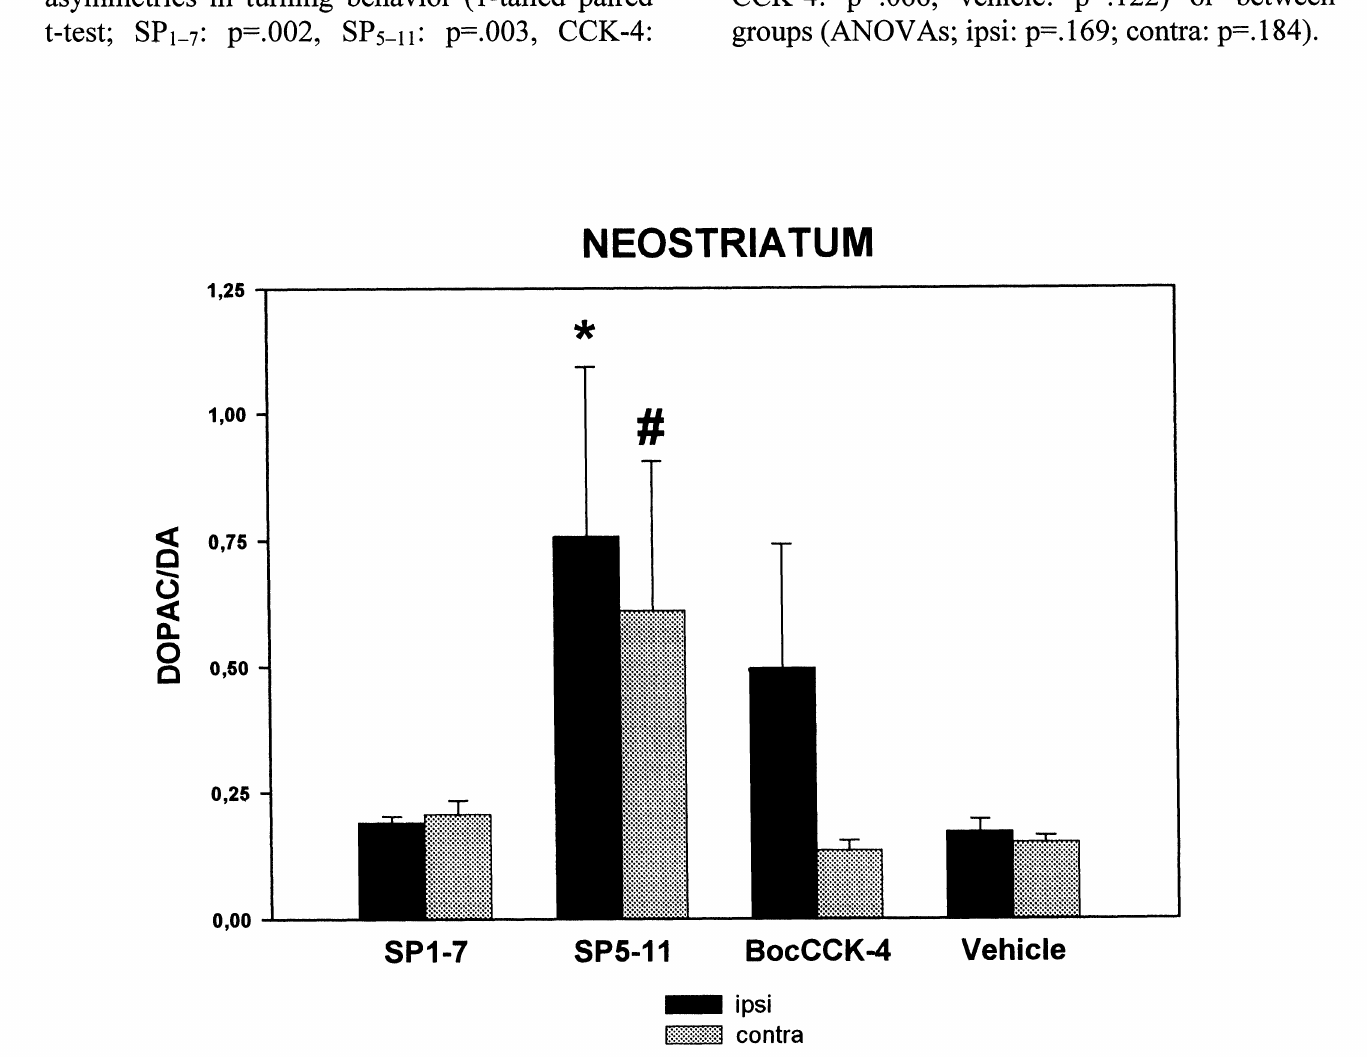
Fig. 1" Ratios of DOPAC/DA (means+SEM) in the neostriatum ipsi- (full bars) and contralateral (gray side of 6-OHDA injection. Data were taken from animals with partial neostriatal neostriatal residual DA levels >10%). Before the 6-OHDA lesion, the animals had been treated systemically for 8 days, either with SP1-7 (14), SP5-11 (n=l 1), CCK-4 (n=9) or with vehicle (n=l 1). Statistical analysis was performed using ANOVAs followed by Duncan’s test: * indicates a difference (p<.05) in comparison with the SP1-7 group; # indicates differences (p<.05) in comparison with vehicle, SP 1-7, and